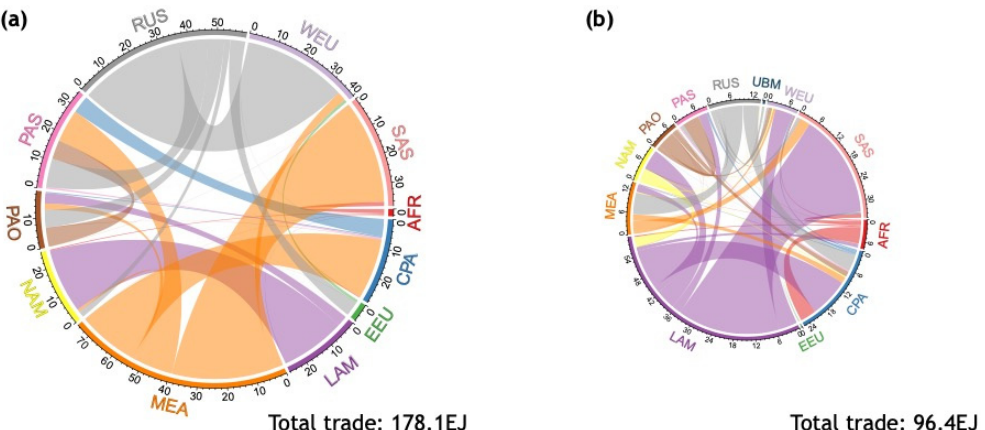
Figure 3. The energy trade network in 2050 under the baseline scenario ( a ) and under an emissions tax scenario ( b ). This figure illustrates the network across energy commodities, (i.e., it is the sum of coal, crude oil, ethanol, fuel oil, light oil, LNG, methanol, and liquid hydrogen). Each chord represents the net export flow. The units of these chord diagrams are in EJ. Regions are represented as follows: AFR = Africa, CPA = Centrally Planned Asia, EEU = Eastern Europe, LAM = Latin America, MEA = Middle East and North Africa, NAM = North America, PAO = Pacific OECD, PAS = Pacific Asia, RUS = Russia, SAS = South Asia, WEU = Western Europe. The color of the traded volume is identical to the exporter region.